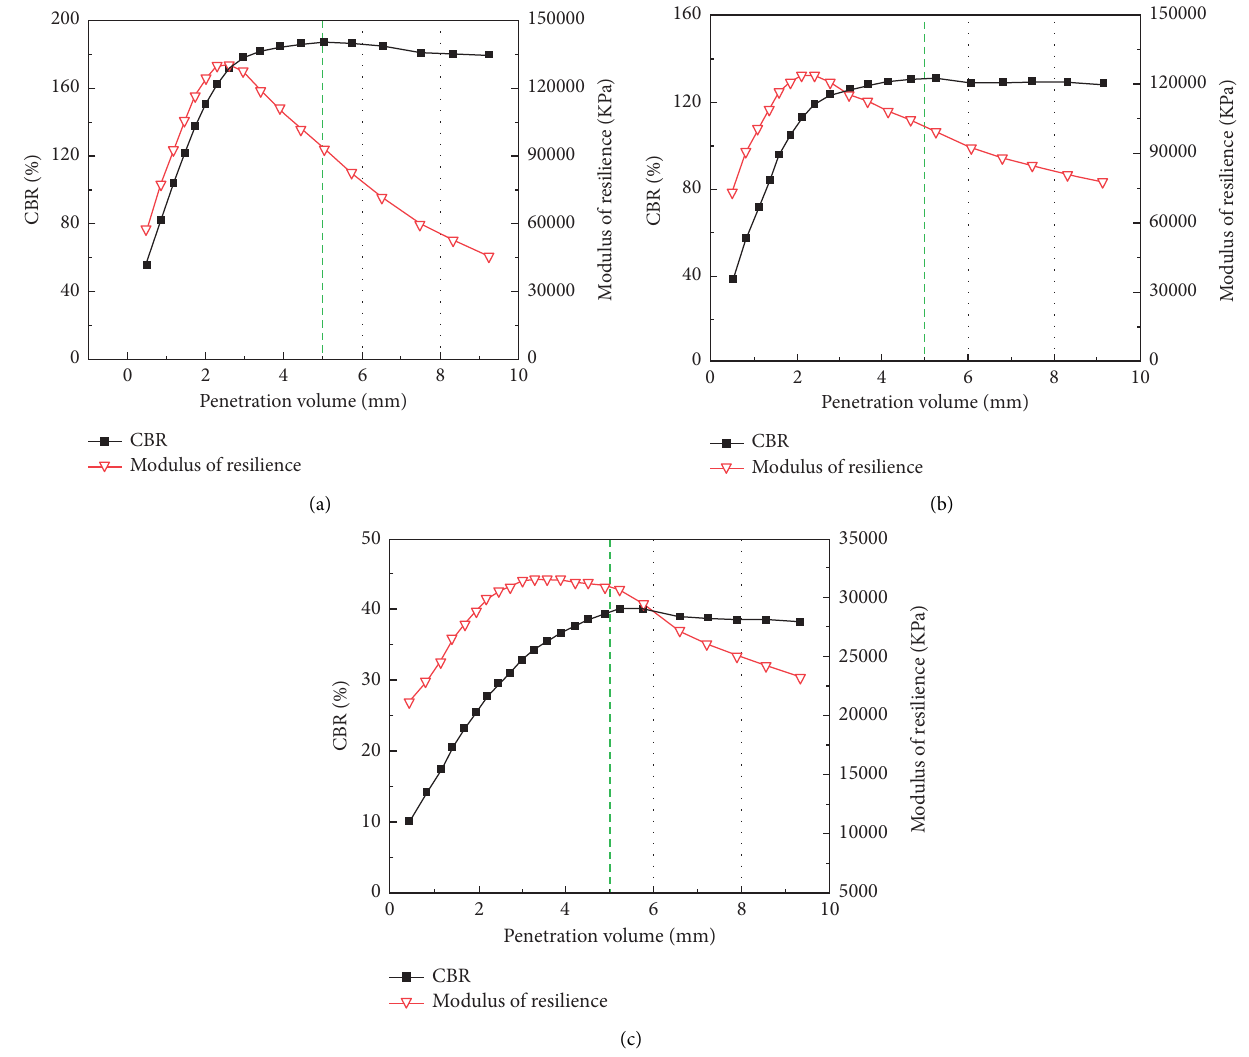
Figure 10: Relationship between CBR and modulus of resilience: (a) 96% compaction, (b) 93% compaction, and (c) 90% compaction. Table 6: Calculation formula of resilient modulus and CBR under different compactness in FSW. Position of filler